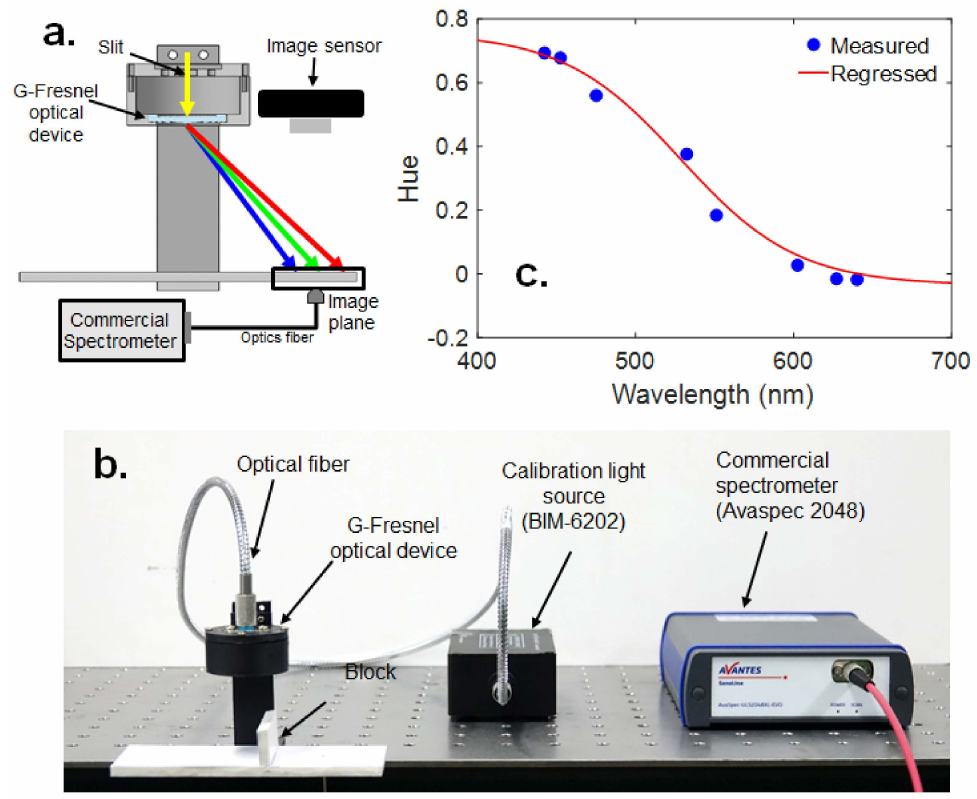
Figure 8. Experimental set-up for calibration: ( a ) schematic, ( b ) photograph, and ( c ) sensitivity curve for calibrating the relationship between wavelength and H